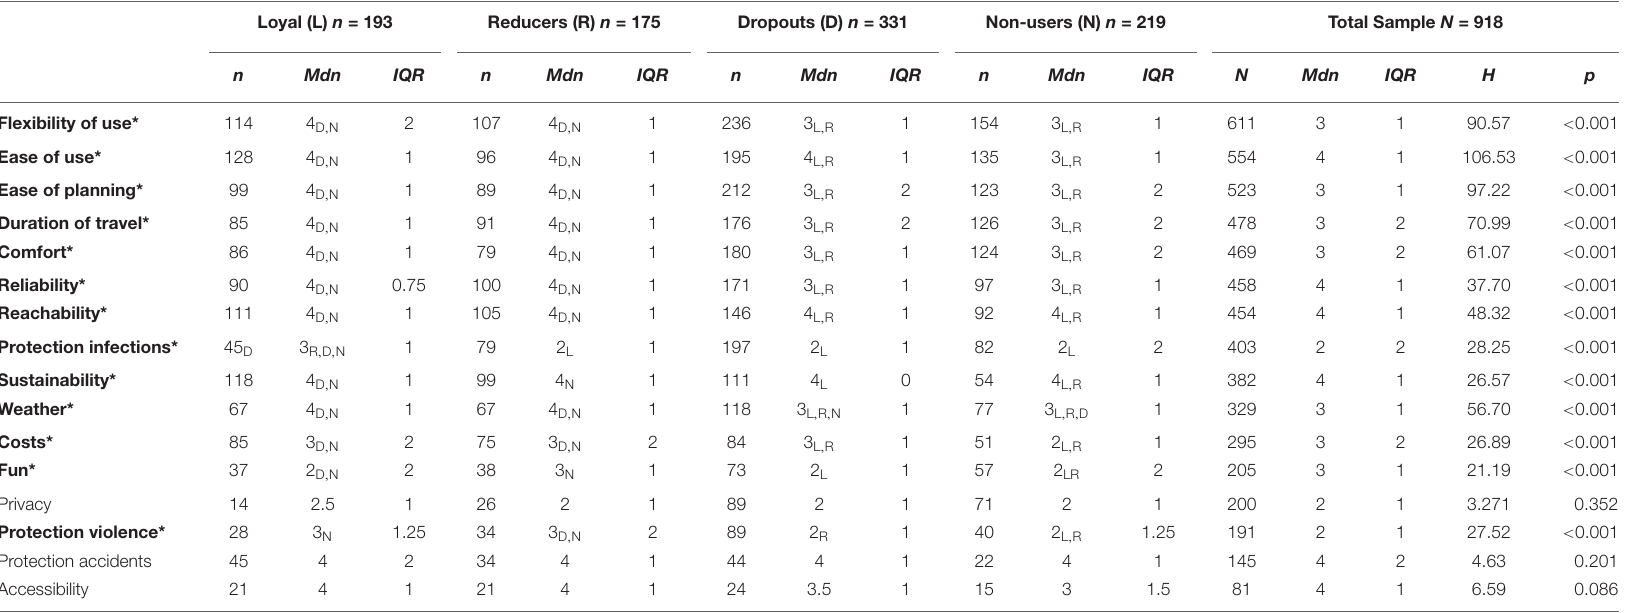
TABLE 4 | Evaluation of criteria regarding public transport evaluated by the four target